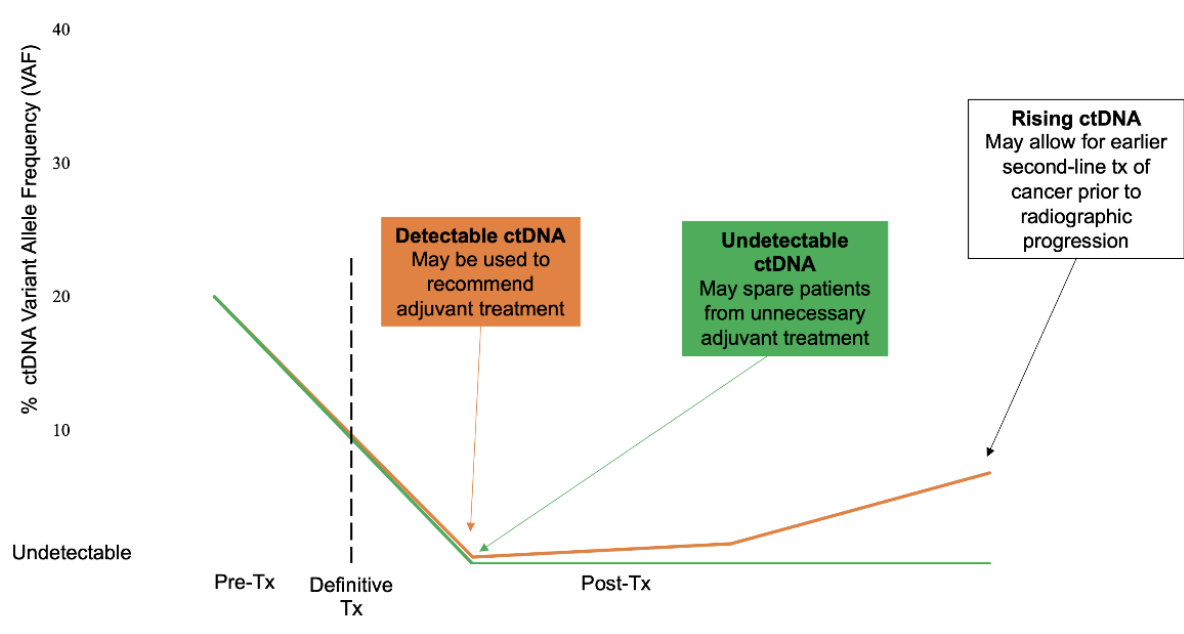
Figure 2. Strategies using ctDNA profiling differ between patients with detectable ctDNA indicating MRD (orange line) and undetectable ctDNA indicating treatment success (green line).